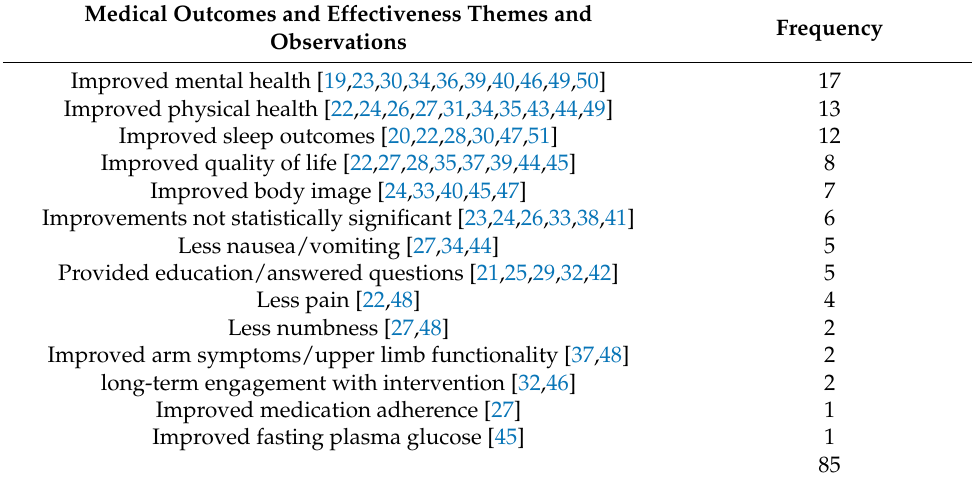
Table 4. Medical outcomes and effectiveness commensurate with the adoption of the intervention. Medical Outcomes and Effectiveness Themes